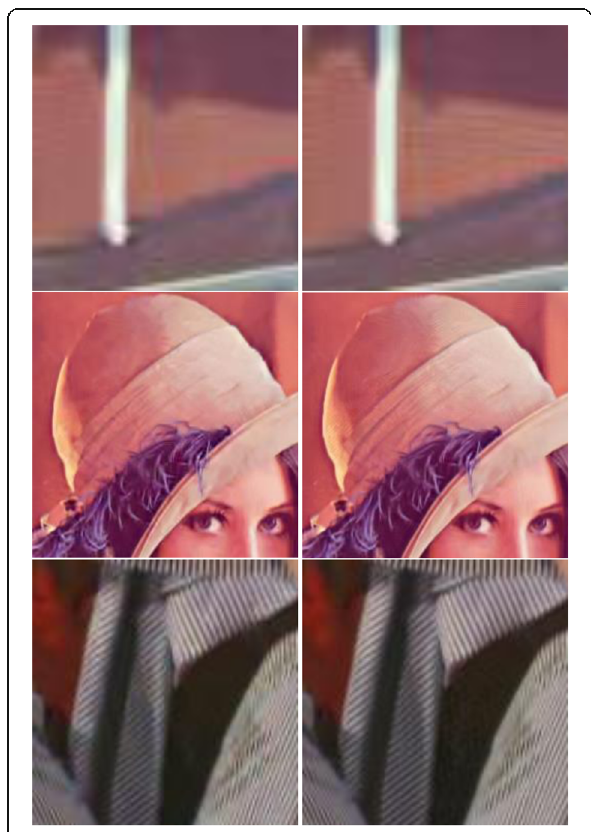
Fig. 9 The denoised results comparison of color image fragments